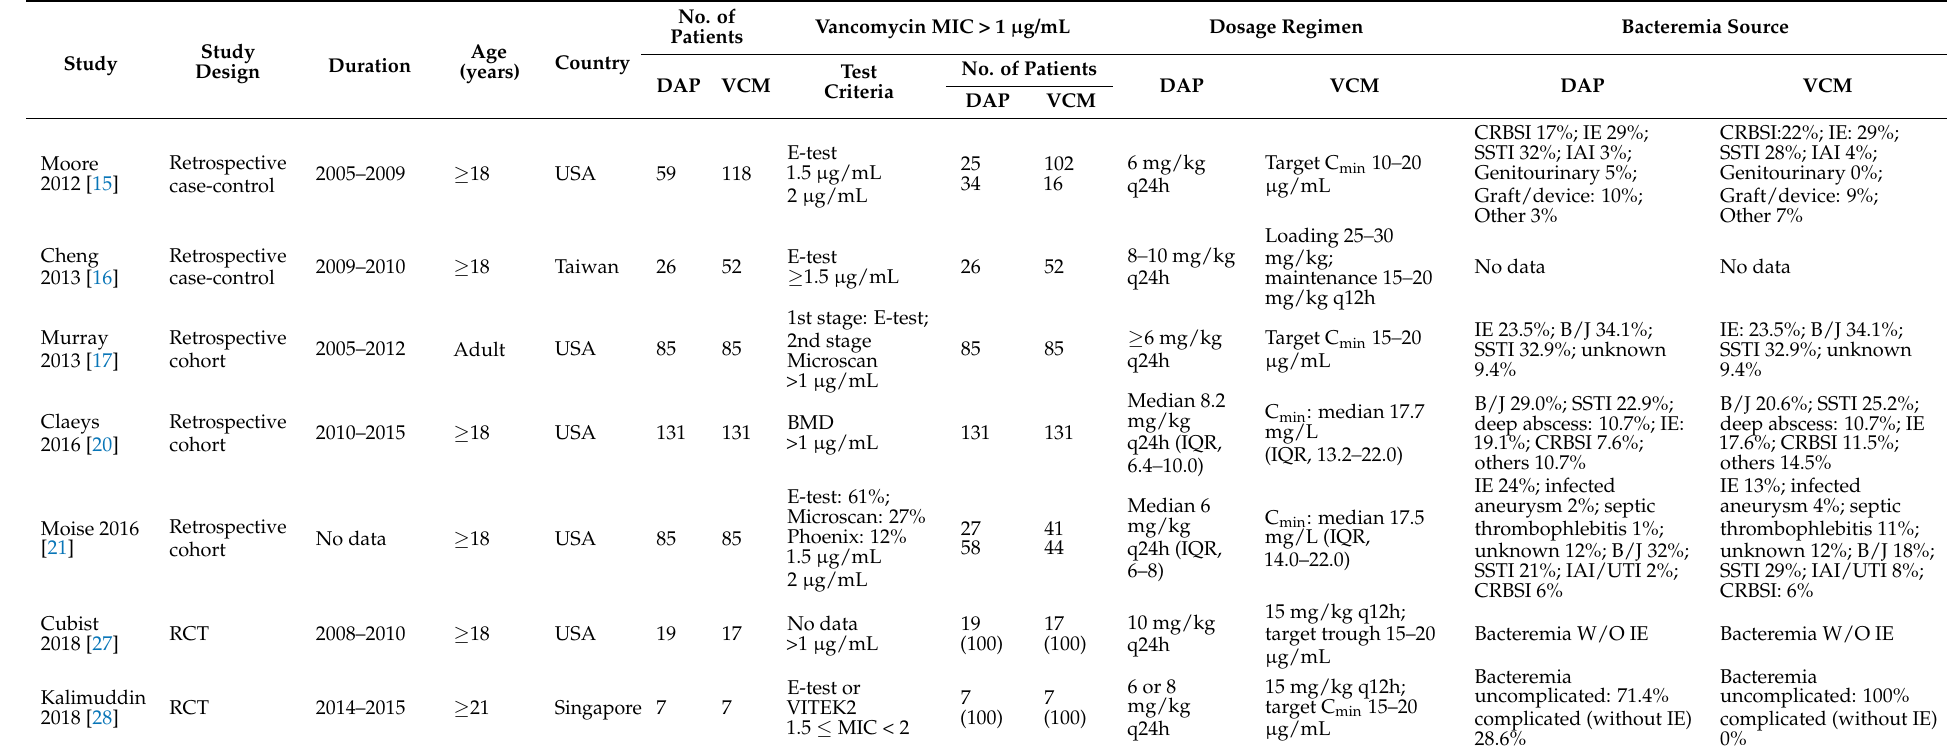
Table 1. Characteristics of studies included in the